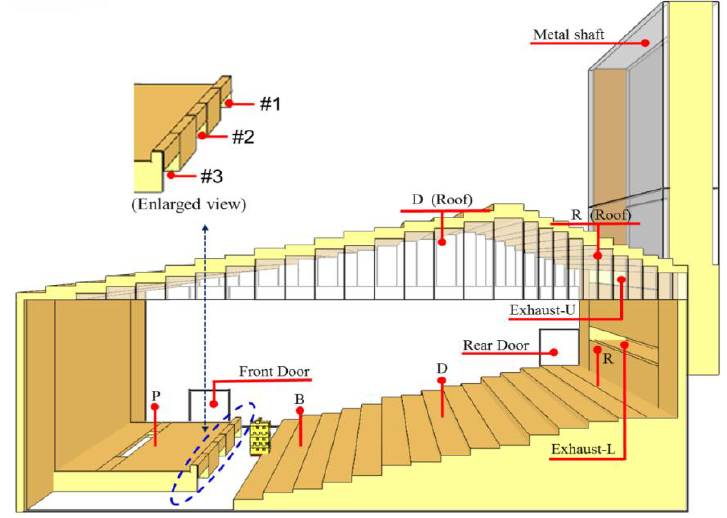
Figure 7. Position and symbol definition of measuring points.